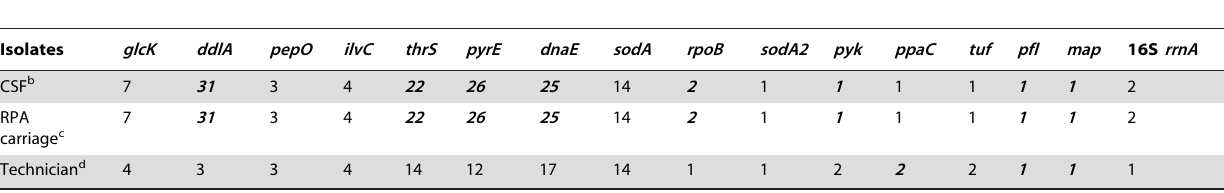
Table 1. Multilocus allele and 16S rRNA gene sequence designation depicting comparison of S. salivarius strain from meningitis patient to oral carriage isolates recovered from radiology physician assistant and technician.